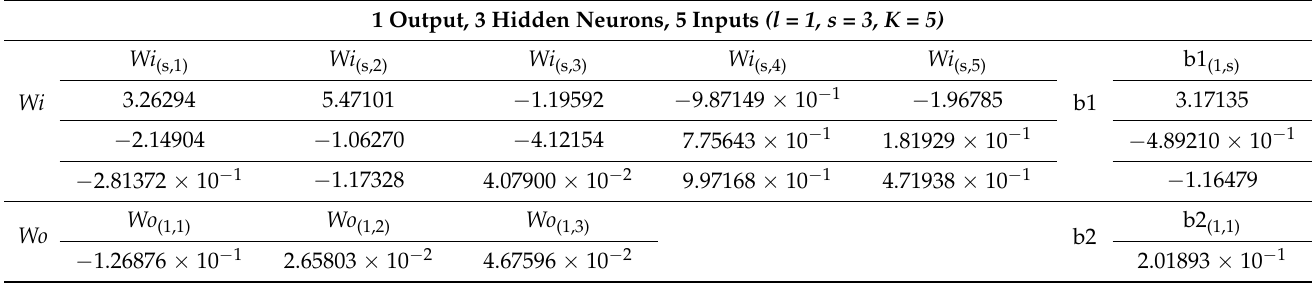
Table 4. Adjusted weights and biases for proposed